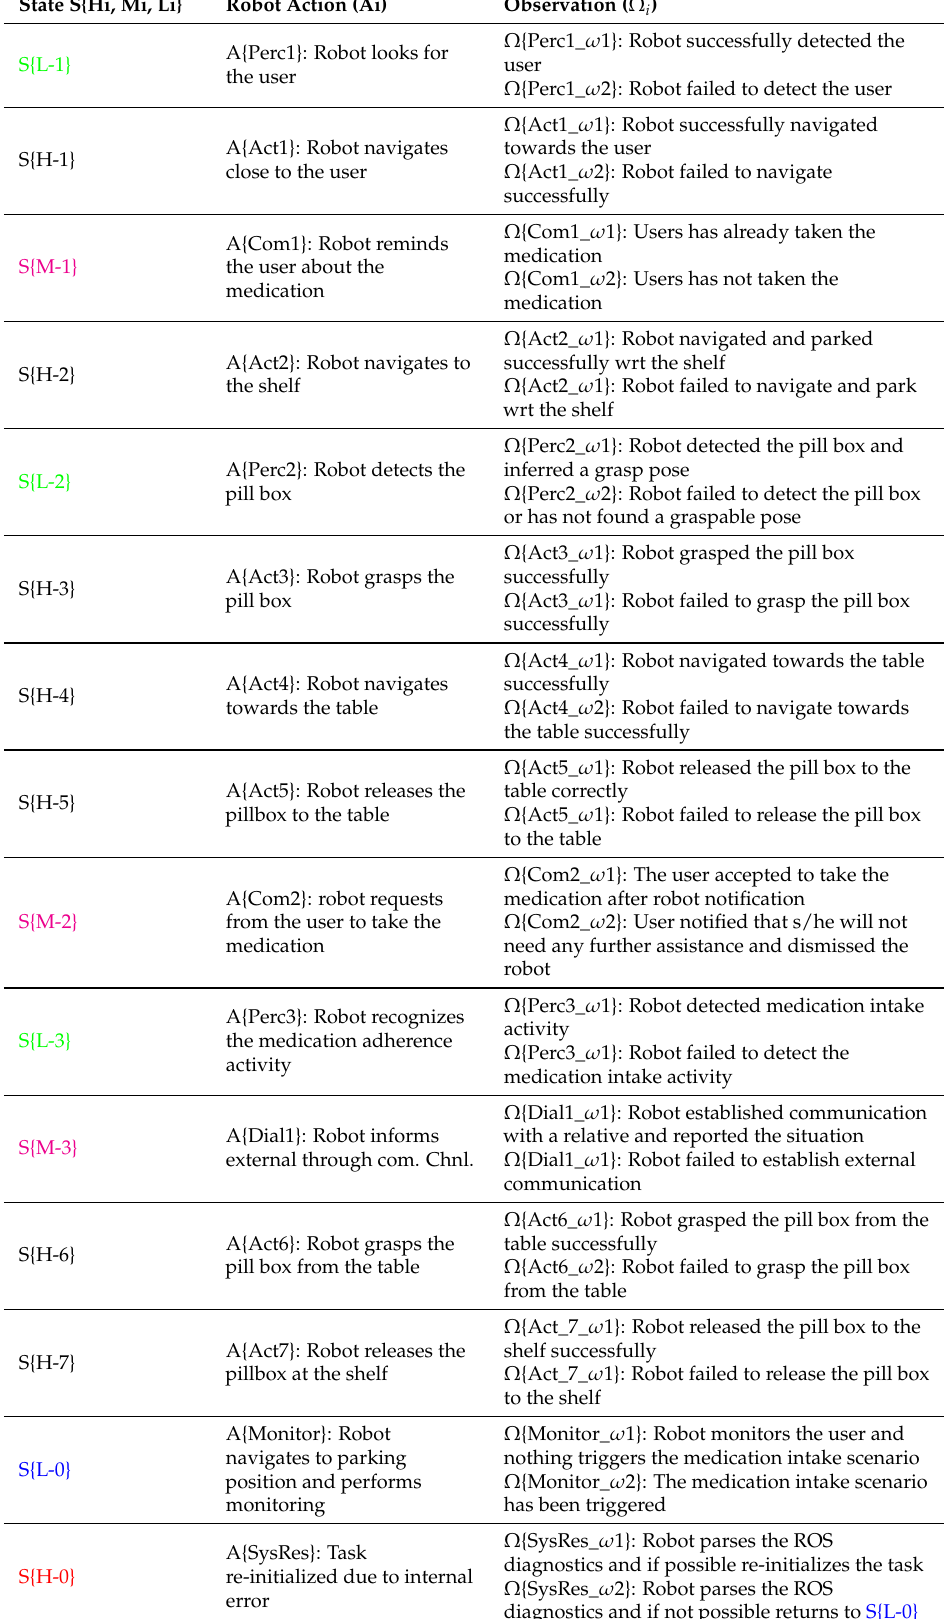
Table 1. The table interprets the states, actions and observations outlined in Figure